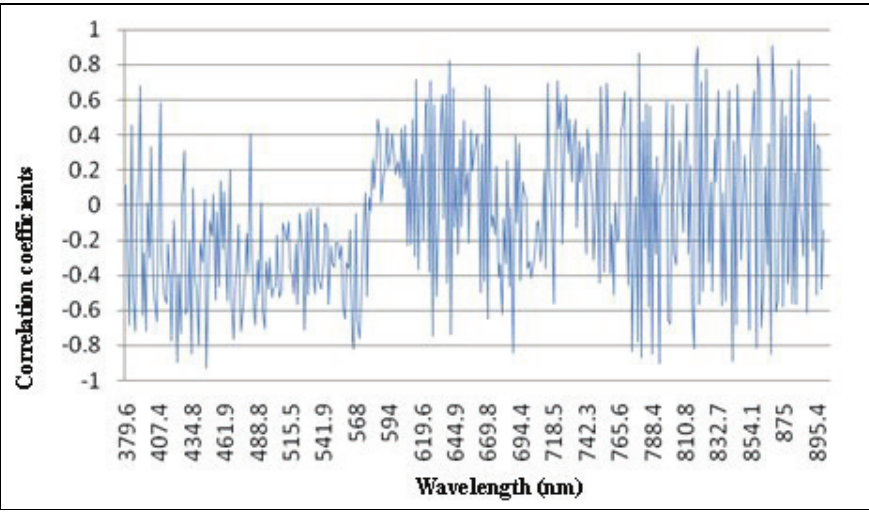
Figure 5. The correlation coefficients between first-derivative of reflectance and Chl- a